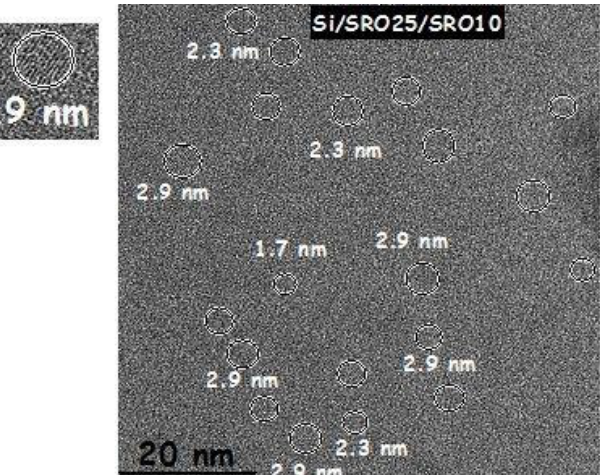
Figure 7. Micrographs of the structure Si/SRO 25 /SRO 100 in the High-Resolution Transmission Electron Microscopy (HRTEM) mode of the SRO films deposited by the Hot Filament Chemical Vapor Deposition (HFCVD) technique, it shows the Si-ncs size (circles).